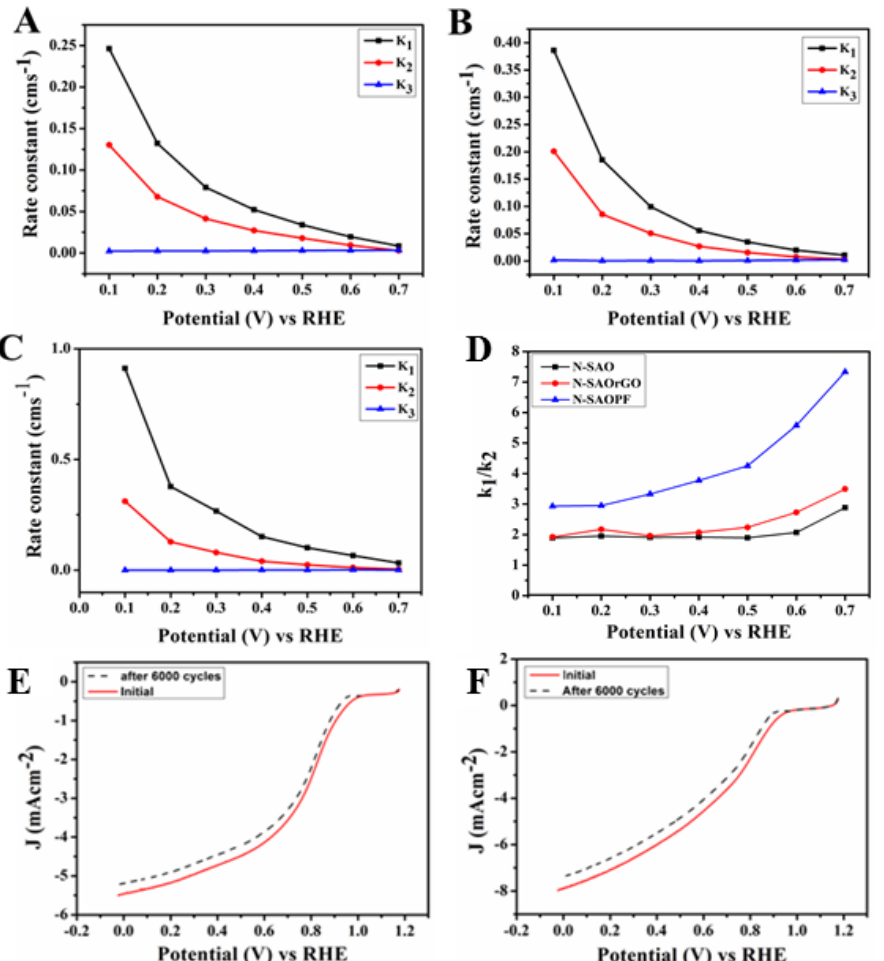
Figure 6. Rate constants of ( A ) N-SAO, ( B ) N-SAOrGO and ( C ) N-SAOPF and ( D ) the ratio of rate constant k 1 /k 2 for N-SAO, N-SAOrGO and N-SAOPF in the potential range of 0.10–0.70 V. Rotating disc electrode polarisation curves of ( E ) N-SAOPF and ( F ) N-SAOrGO with a scan rate of 10 mVs −1 before and after 6000 potential cycles in 0.10 M Oxygen saturated KOH.